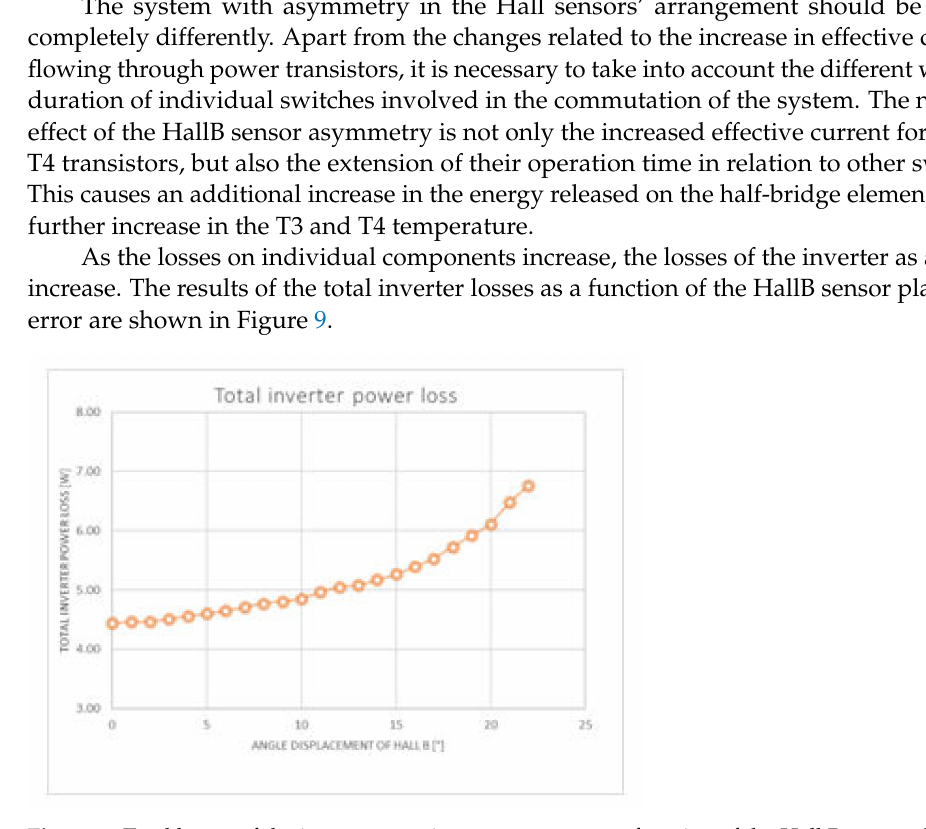
Figure 9. Total losses of the inverter transistor connectors as a function of the Hall B sensor shift from the optimal